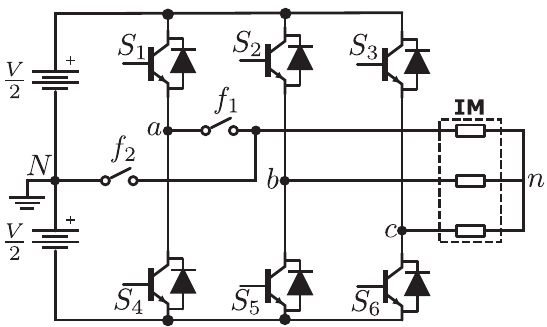
Figure 15. Schematic diagram of a typical fault-tolerant inverter. Under normal operating conditions, switch f 1 is closed, f 2 is open, and the motor is supplied from the typical inverter ( S 1 – S 6